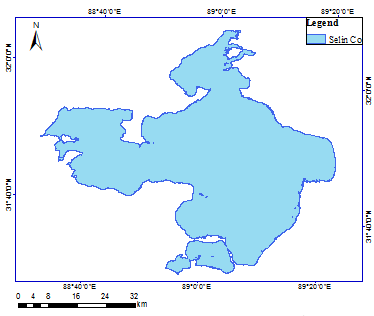
Figure 4. Geographical location of Selin Co